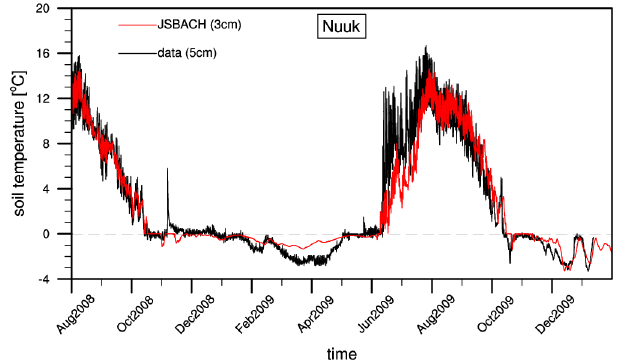
Fig. 2. Observed and simulated upper-layer soil temperature at the Nuuk site. Observed soil temperature at 5cm is plotted with the black line and the red line shows the JSBACH-simulated soil tem- perature in the first layer (ca. 3cm).